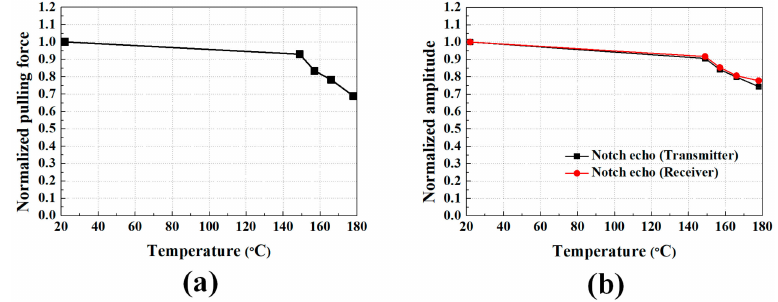
Figure 8. ( a ) The normalized pull force and ( b ) the normalized notch echo for neodymium magnets at room temperature after thermal exposure.